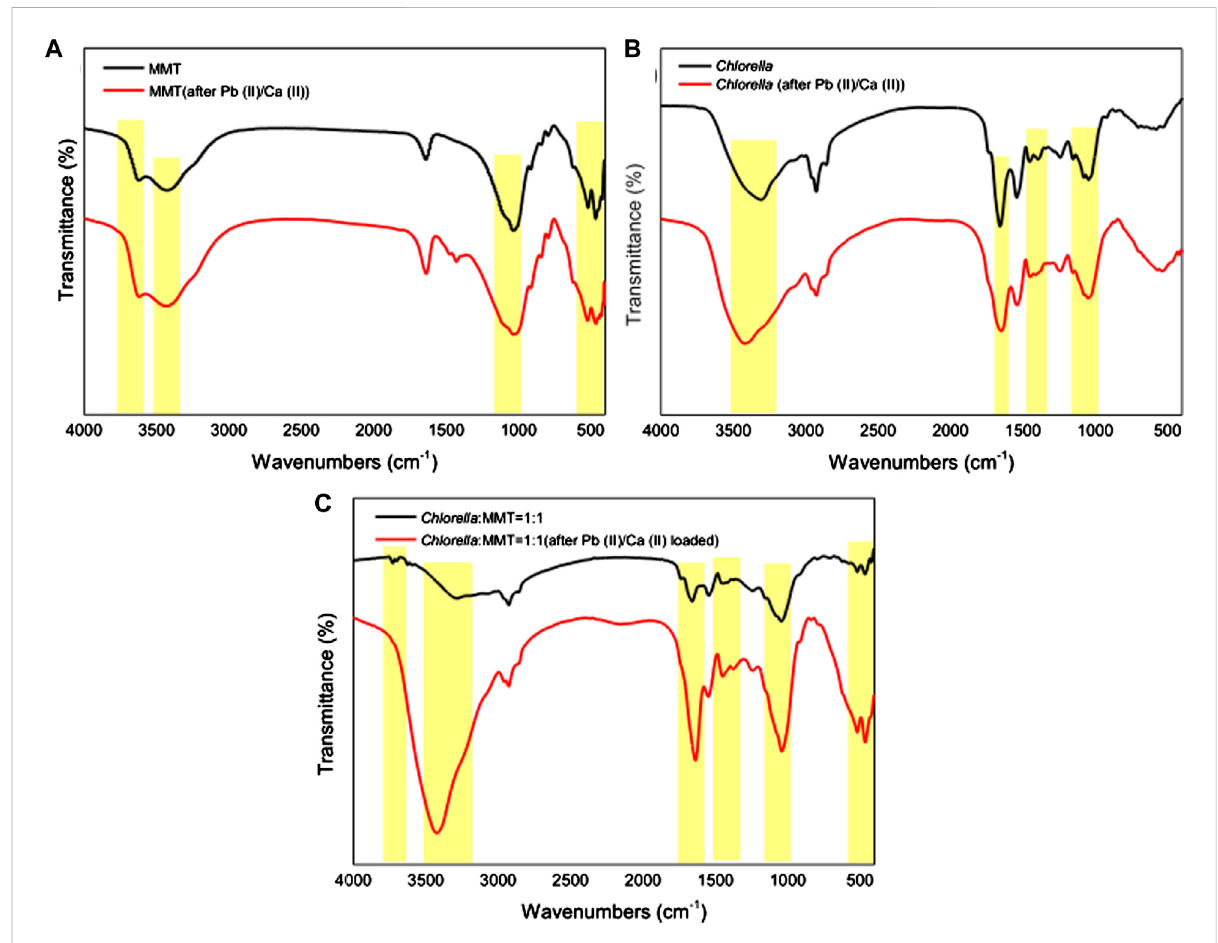
FIGURE 7 FT-IR spectra of (A) MMT, (B) Chlorella , and (C) Chlorella – MMT (1:1) composite before and after Pb(II)/Ca(II)